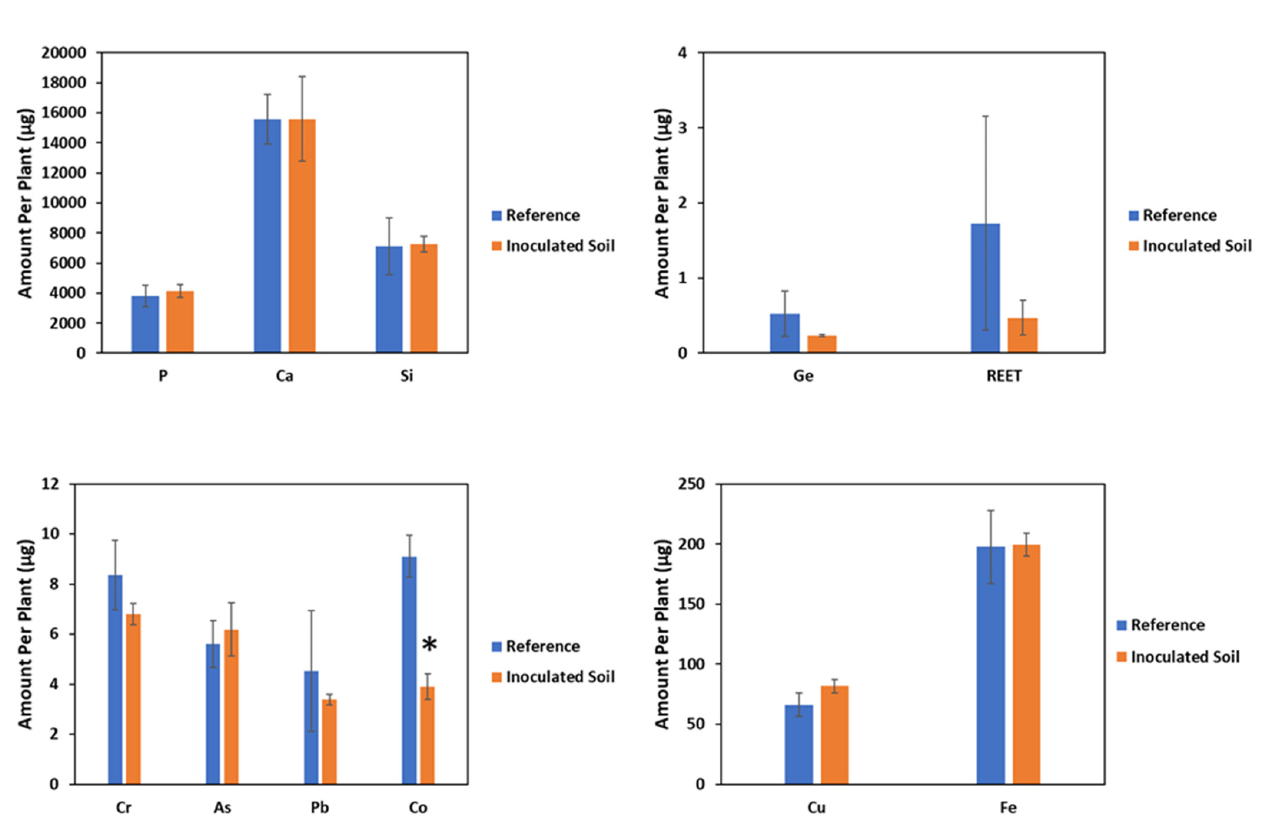
Figure 3. Effect of inoculation on phytoaccumulation of investigated elements by Zea mays . Significant difference ( p ≤ 0.1) between means indicated by asterisk * (mean ± SE, n = 3).